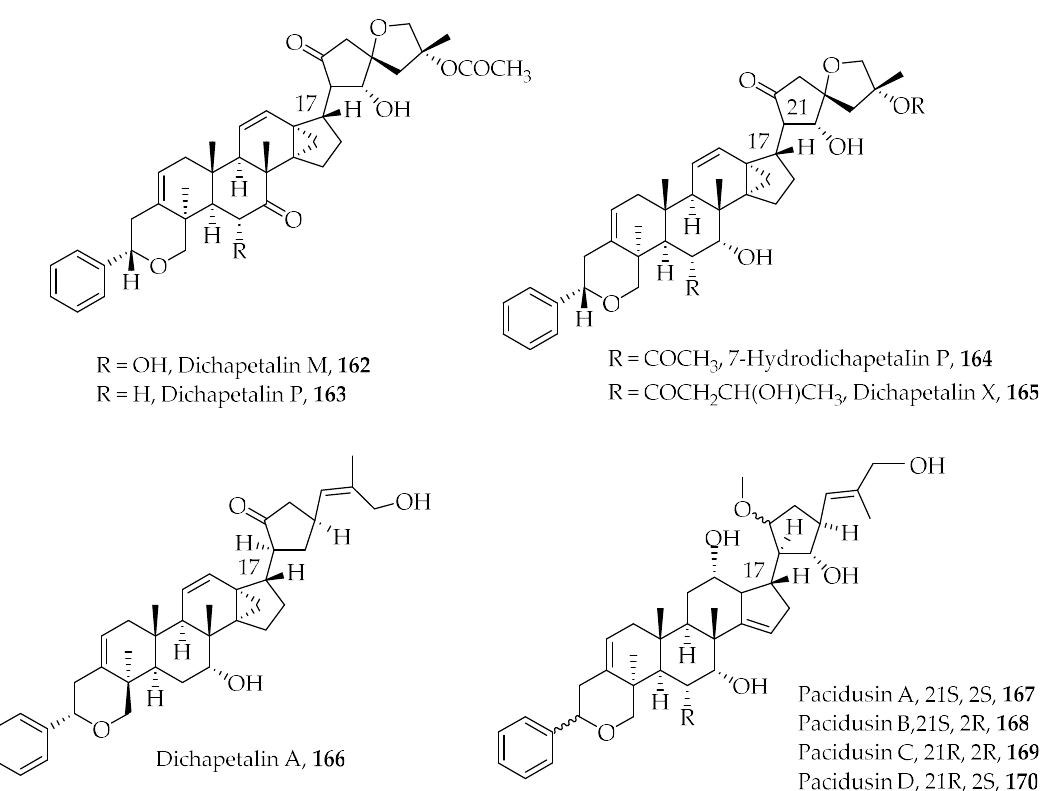
Figure 41. Structures of the triterpenoids Dichapetalins M, P, X and A, 7-Hydroxydichapetalin P, as well as Pacidusins A-D.